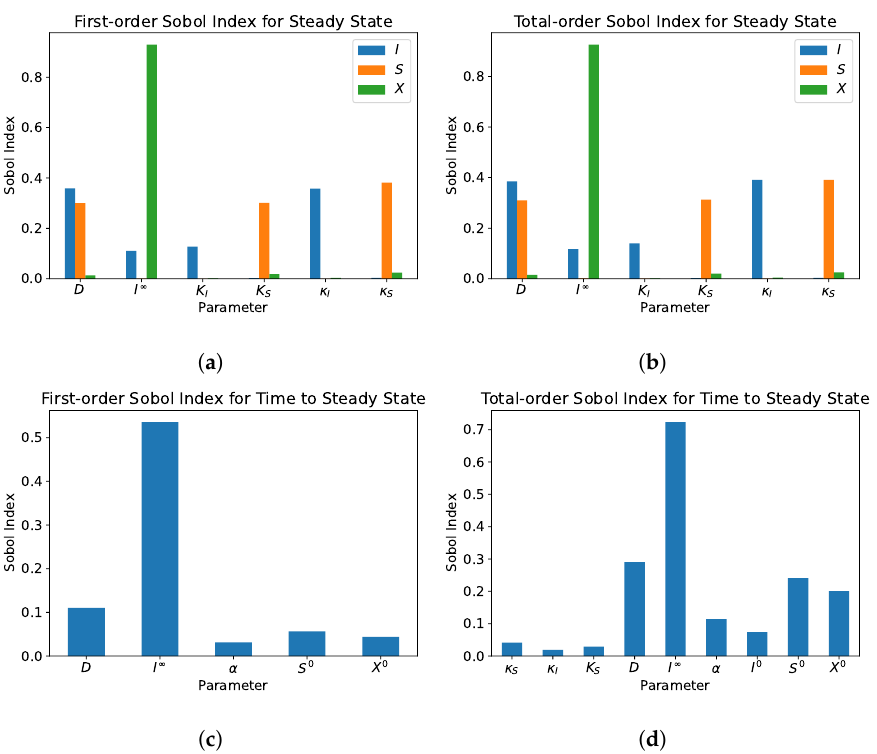
Figure 8. ( a ) First-order and ( b ) total effect sensitivity indices of steady-state values of fiber I , sugar S and biomass X . ( c ) First-order and ( d ) total effect sensitivity indices of time to steady state values of fiber I , sugar S and biomass X for a parameter set that tends to the positive steady state. Sampling was conducted with a variance of 20% on input parameters, excluding yield coefficients. Mean values were taken from Table